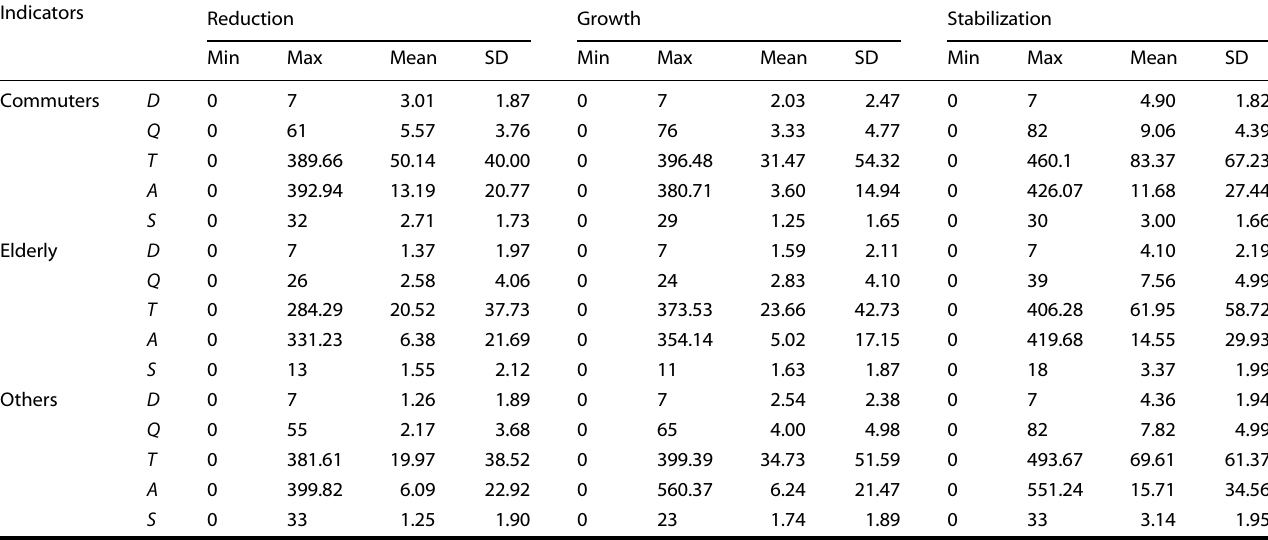
Table 1. Mobility indicators during three sequential phases by groups.